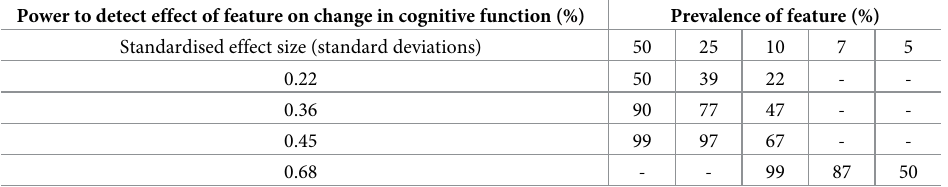
Table 2. Power of the MOTION study to detect difference in cognitive function between groups defined by fea- tures of the microbiome. Power to detect effect of feature on change in cognitive function (%) Prevalence of feature (%) Standardised effect size (standard